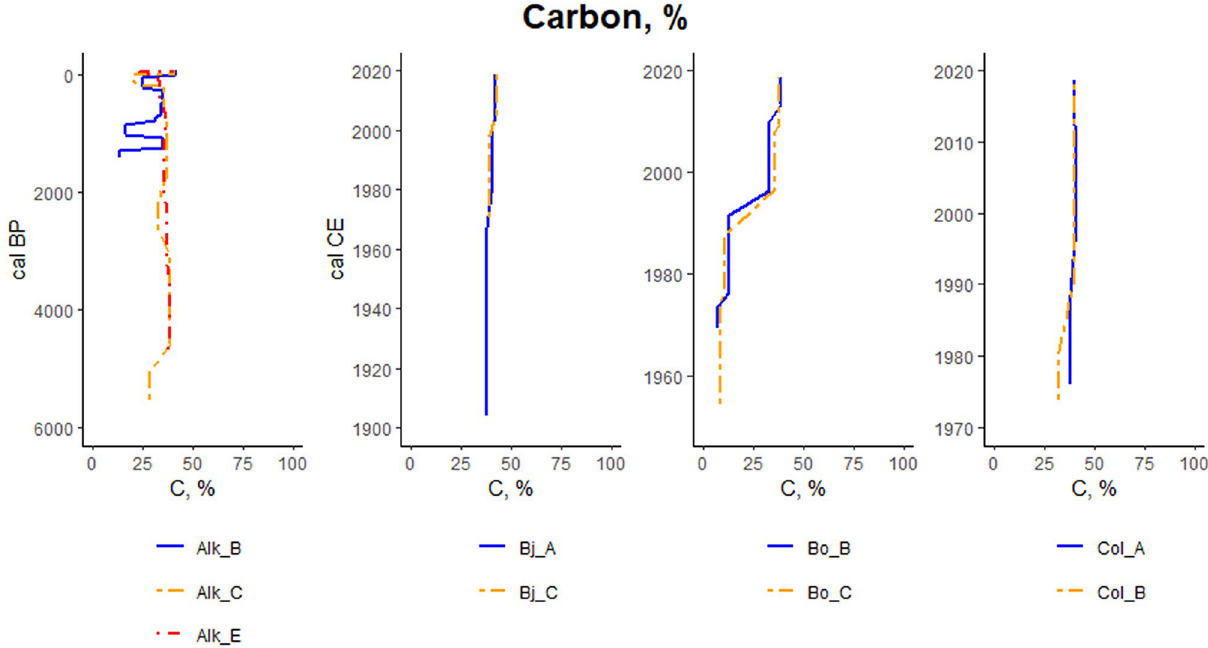
Figure 11. Carbon content (%) variation at different soil layers for focus section study points. Each panel represent different study site. For the study site Alkhornet (Alk), age is presented as calibrated Before Present (cal BP) while for Bjørndalen (Bj), Bolterdalen (Bo) and Colesdalen (Col) ages are presented as calibrated Common Era (cal, CE).